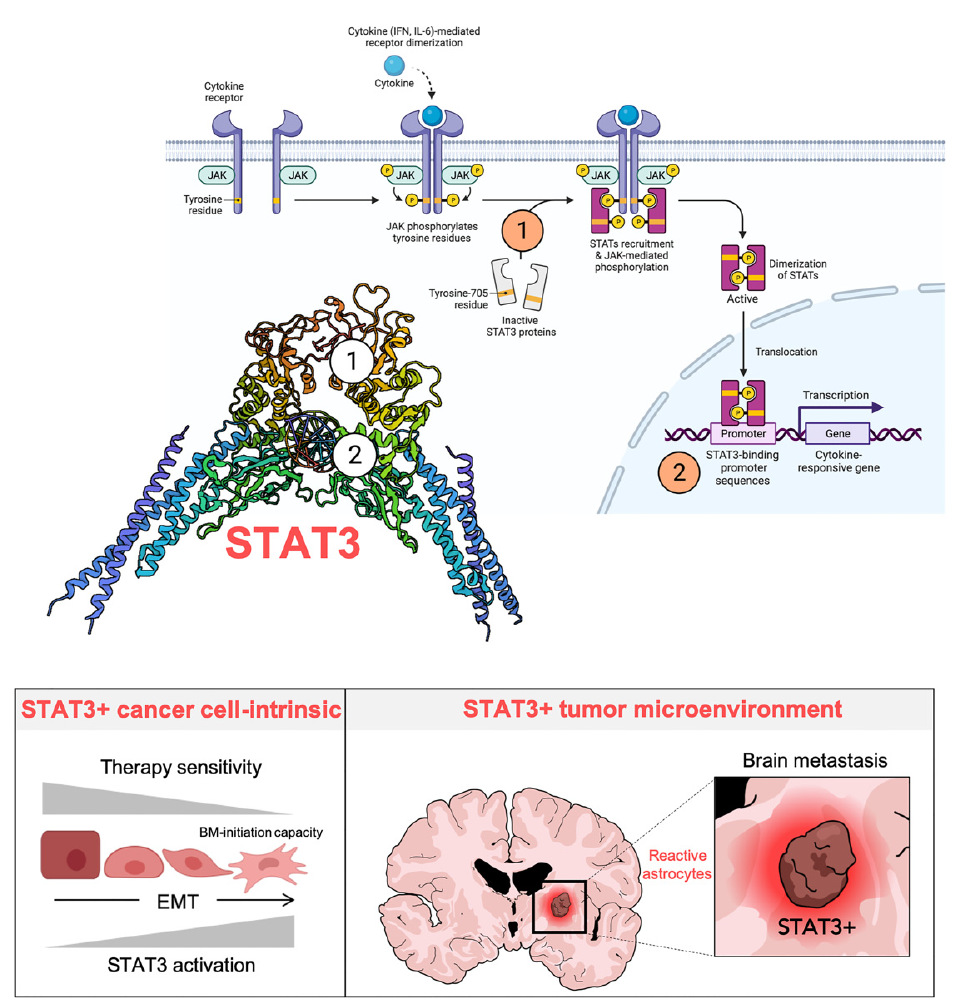
Figure 3. Silibinin mechanism of action in lung cancer: A STAT3-centric view. Aberrant activation of JAK/STAT3 signaling, in particular STAT3, participates in the initiation, development, and therapeutic resistance of lung cancer via promotion of proliferation, survival, inflammation, angiogenesis, and metastasis. Silibinin is a unique blocker of the JAK/STAT3 signal transduction cascade that operates as a bimodal SH2- and DBD-targeting direct STAT3 inhibitor (STAT3i) while sparing JAK activity. STAT3 participates in multiple layers of the EMT regulatory network, and feedback activation of STAT3 is a common cause of resistance to many chemotherapies and targeted cancer therapies. At the lung cancer cell-intrinsic level, silibinin-containing combinatorial treatments can overcome drug resistance and reduce the brain metastasis-initiating capacity of lung cancer cells. Brain metastasis cells promote the co-option of a pro-metastatic program driven by STAT3 activation in a subpopulation of reactive astrocytes surrounding metastatic lesions. Blocking microenvironmental STAT3 signaling in reactive astrocytes with silibinin reduces the growth of brain metastases from primary NSCLC tumors, even at advanced stages of colonization. Created with BioRender.